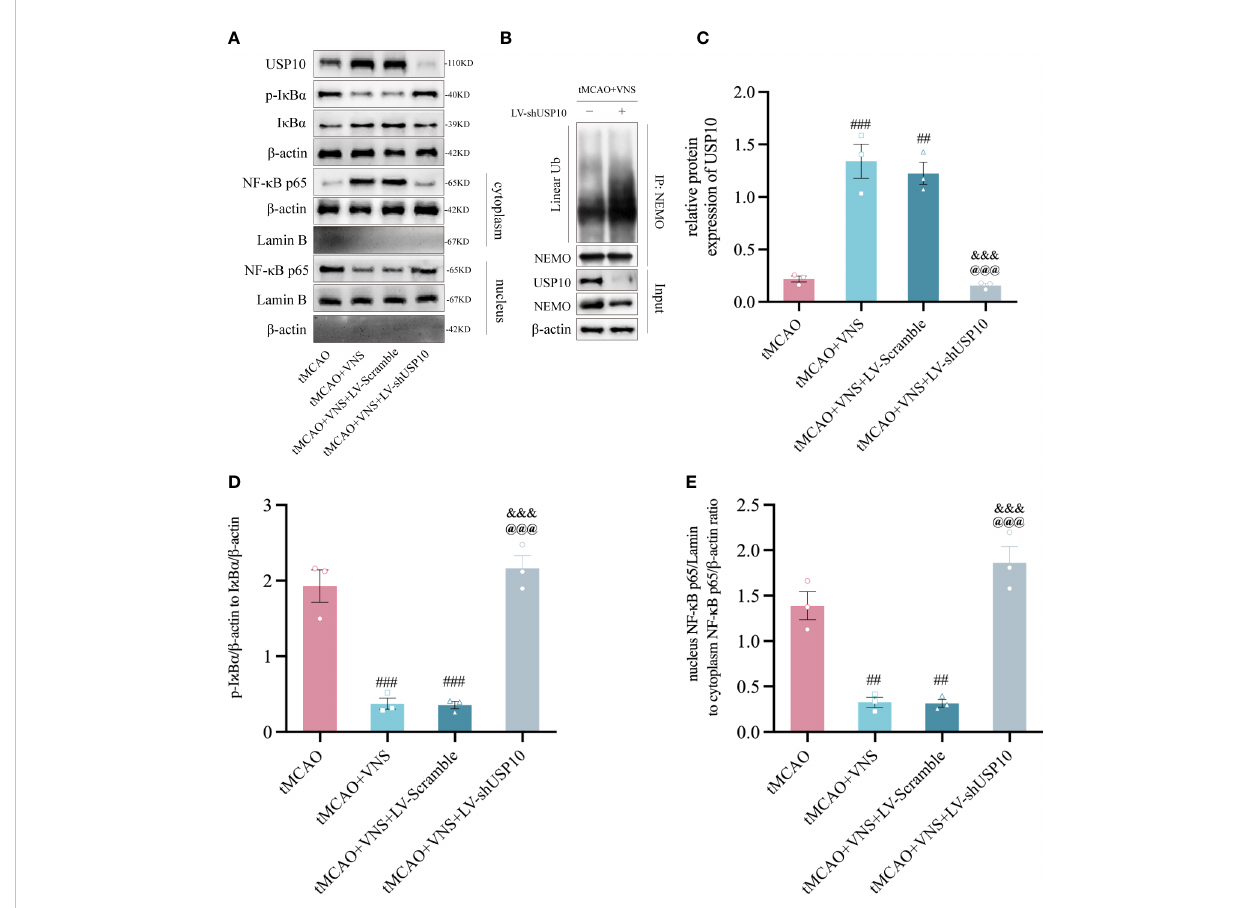
FIGURE 3 VNS inhibited the NF- k B signaling pathway by elevating the USP10 expression level. (A) Western blotting showed the protein expression of USP10, p- I k B a , I k B a , cytoplasmic-p65, and nuclear-p65. b -actin: the control for total or cytoplasmic proteins. Lamin B: the control for nuclear proteins. n=3; (B) immunoprecipitation assays showed the effect of USP10 silencing on the linear ubiquitination of NEMO. (C – E) Histogram of the USP10 protein expression (C) , I k B a phosphorylation ratio (D) , and the ratio of nuclear to cytoplasmic NF- k B p65 (E) . n=3; Data are mean ± SEM. ###P<0.001, ##P<0.01, and #P<0.05 vs. tMCAO group. @@@P<0.001 vs. tMCAO+VNS group. &&&P<0.001 vs. tMCAO+VNS+LV-Scramble